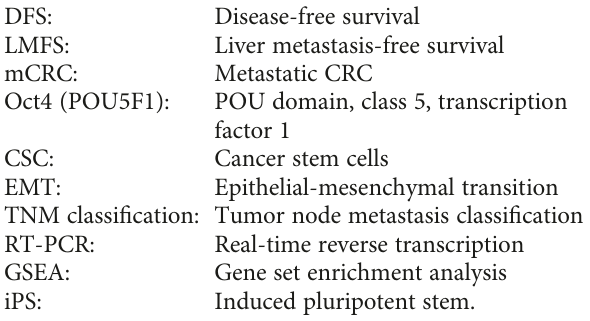
Table S1: primer sequences corresponding to universal probe libraries. Table S2: pathways enriched in Oct4-EGFP-high cells. Figure S1: distribution of Oct4 mRMA expression levels in tumor samples. Figure S2: distribution of Oct4 mRMA expression levels strati fi ed by liver metastasis status and TNM stage. Figure S3: survival curves for overall survival (OS) and disease-free survival (DFS) according to POU5F1 mRNA expression. Figure S4: fl ow cytometry analysis of CD24 and CD44 in cell lines and iCC Agilent microarray protocol. (Supplementary